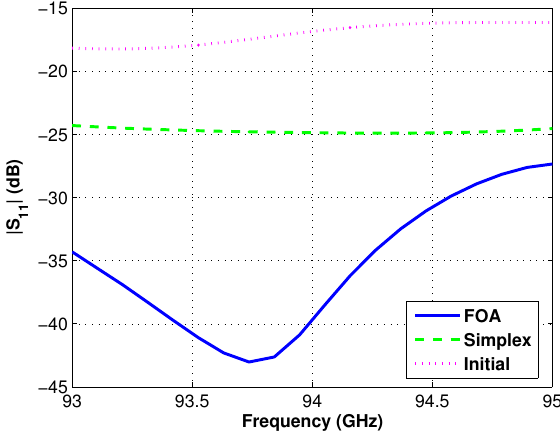
Figure 11. Magnitude of the S 11 parameter of the optimized Potter Horn.